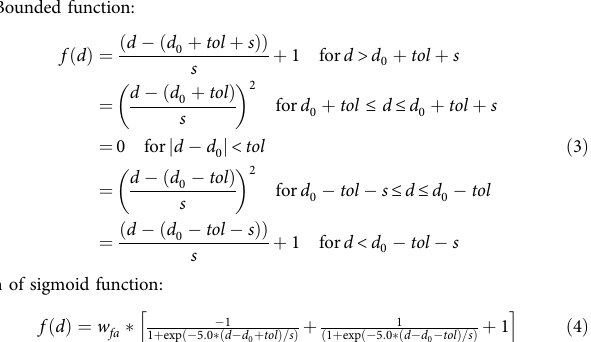
(Fig. 1b): fi rst initial model diversi fi cation stage, followed by iterative model intensi fi cation stages where a pool of structures is maintained during